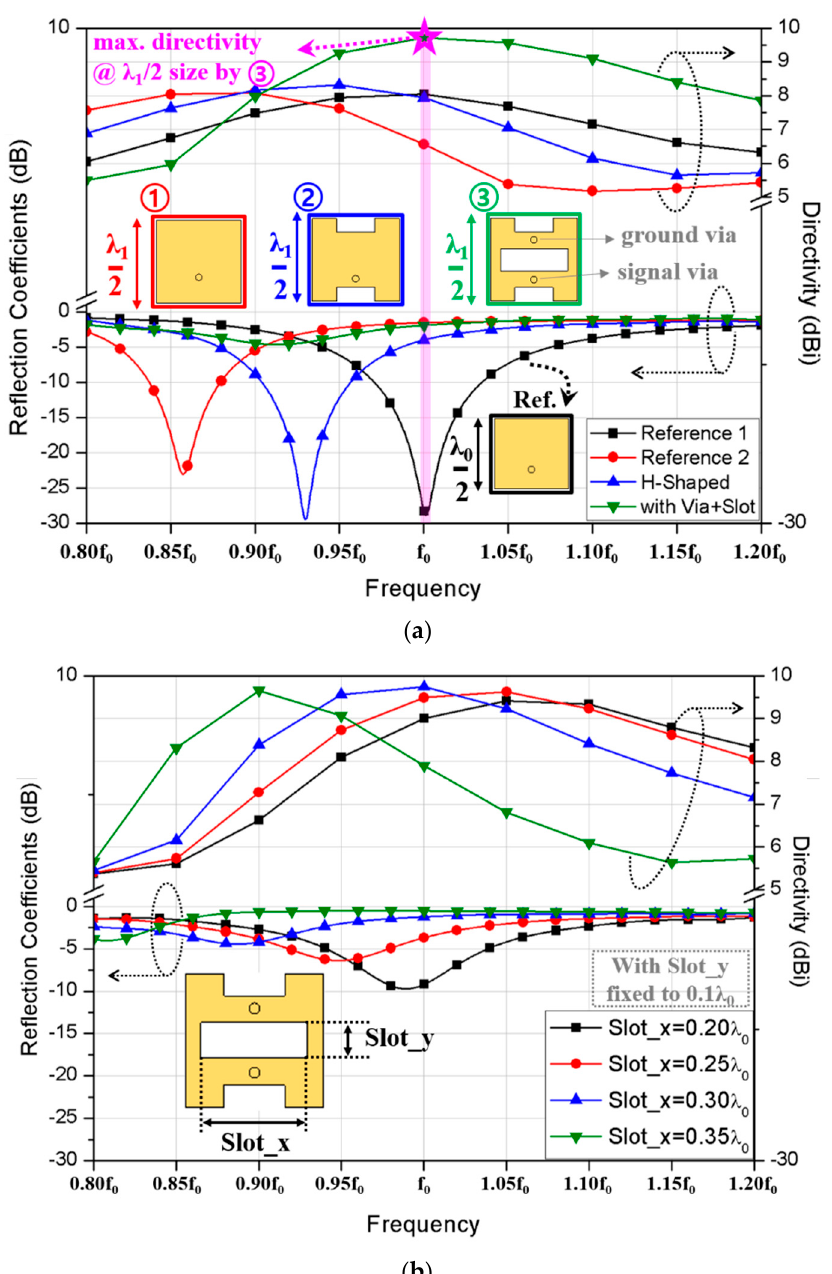
Figure 1. Reflection coefficient and directivity behaviors for ( a ) different types of planar patches and ( b ) a proposed slot-loaded patch with a shorting pin.